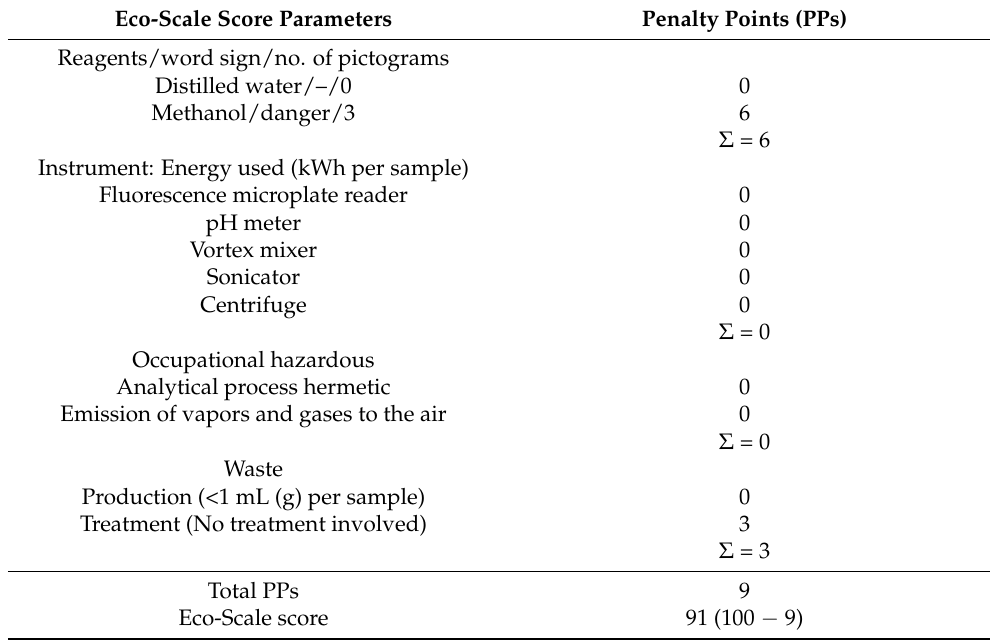
Table 6. Analytical Eco-Scale for assessing of the greenness of the proposed MW-SFA. Eco-Scale Score Parameters Penalty Points (PPs) Reagents/word sign/no. of pictograms